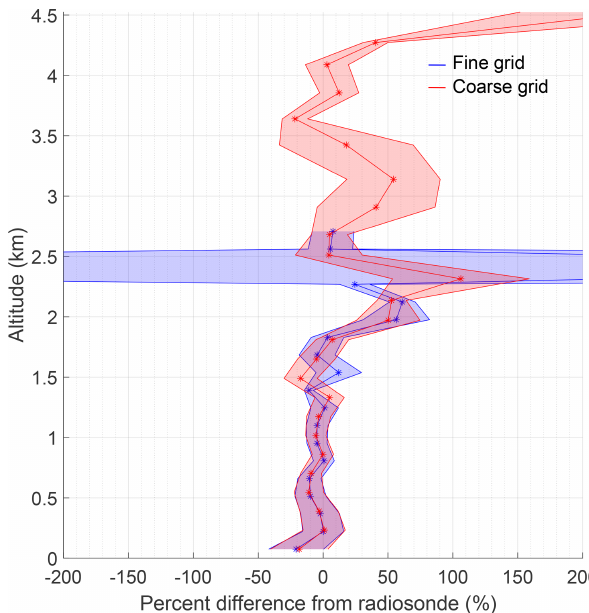
Figure 6. The relative percent difference between the radiosonde and the fine- and coarse-grid retrievals on 22 January 2013 12:00UT. The 1 σ uncertainties for percent difference are shown as shaded regions. The fine-grid results are shown in blue and the coarse-grid results in red. The largest percent difference for the fine grid is 600% and is not shown.